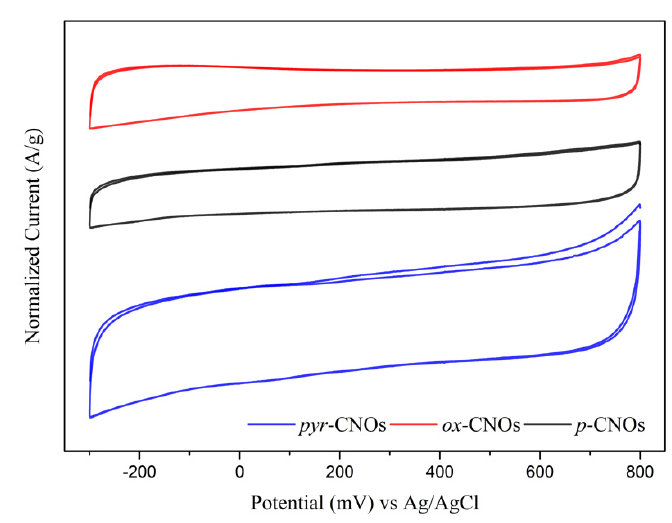
Figure 8. Cyclic voltammetry (CV) curves of the glassy carbon electrode that was covered with the functionalized and non-functionalized CNOs in 1.0 M Na 2 SO 4 , obtained with a sweep rate of 30 mV/s.